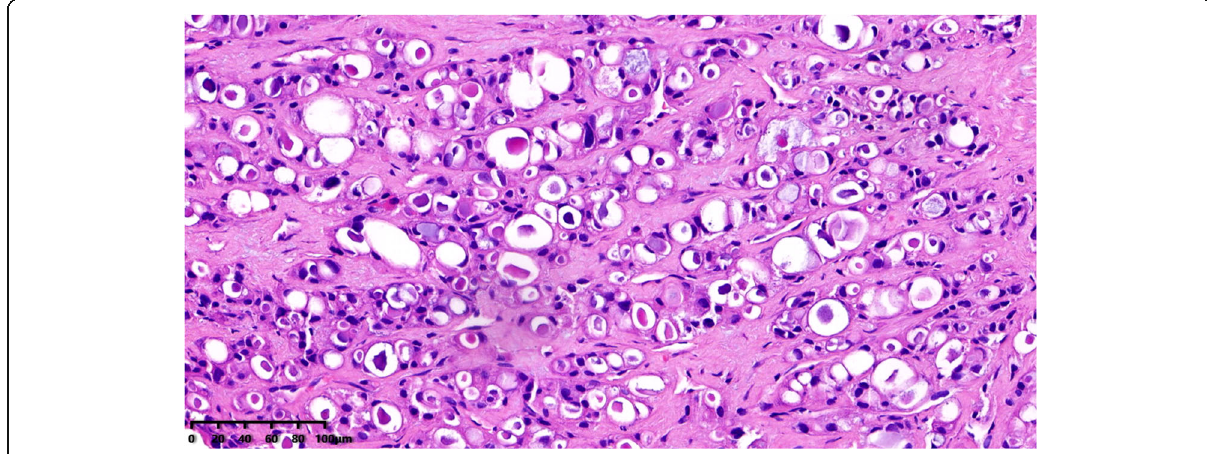
Fig. 1 The metastatic carcinoma in liver. HE